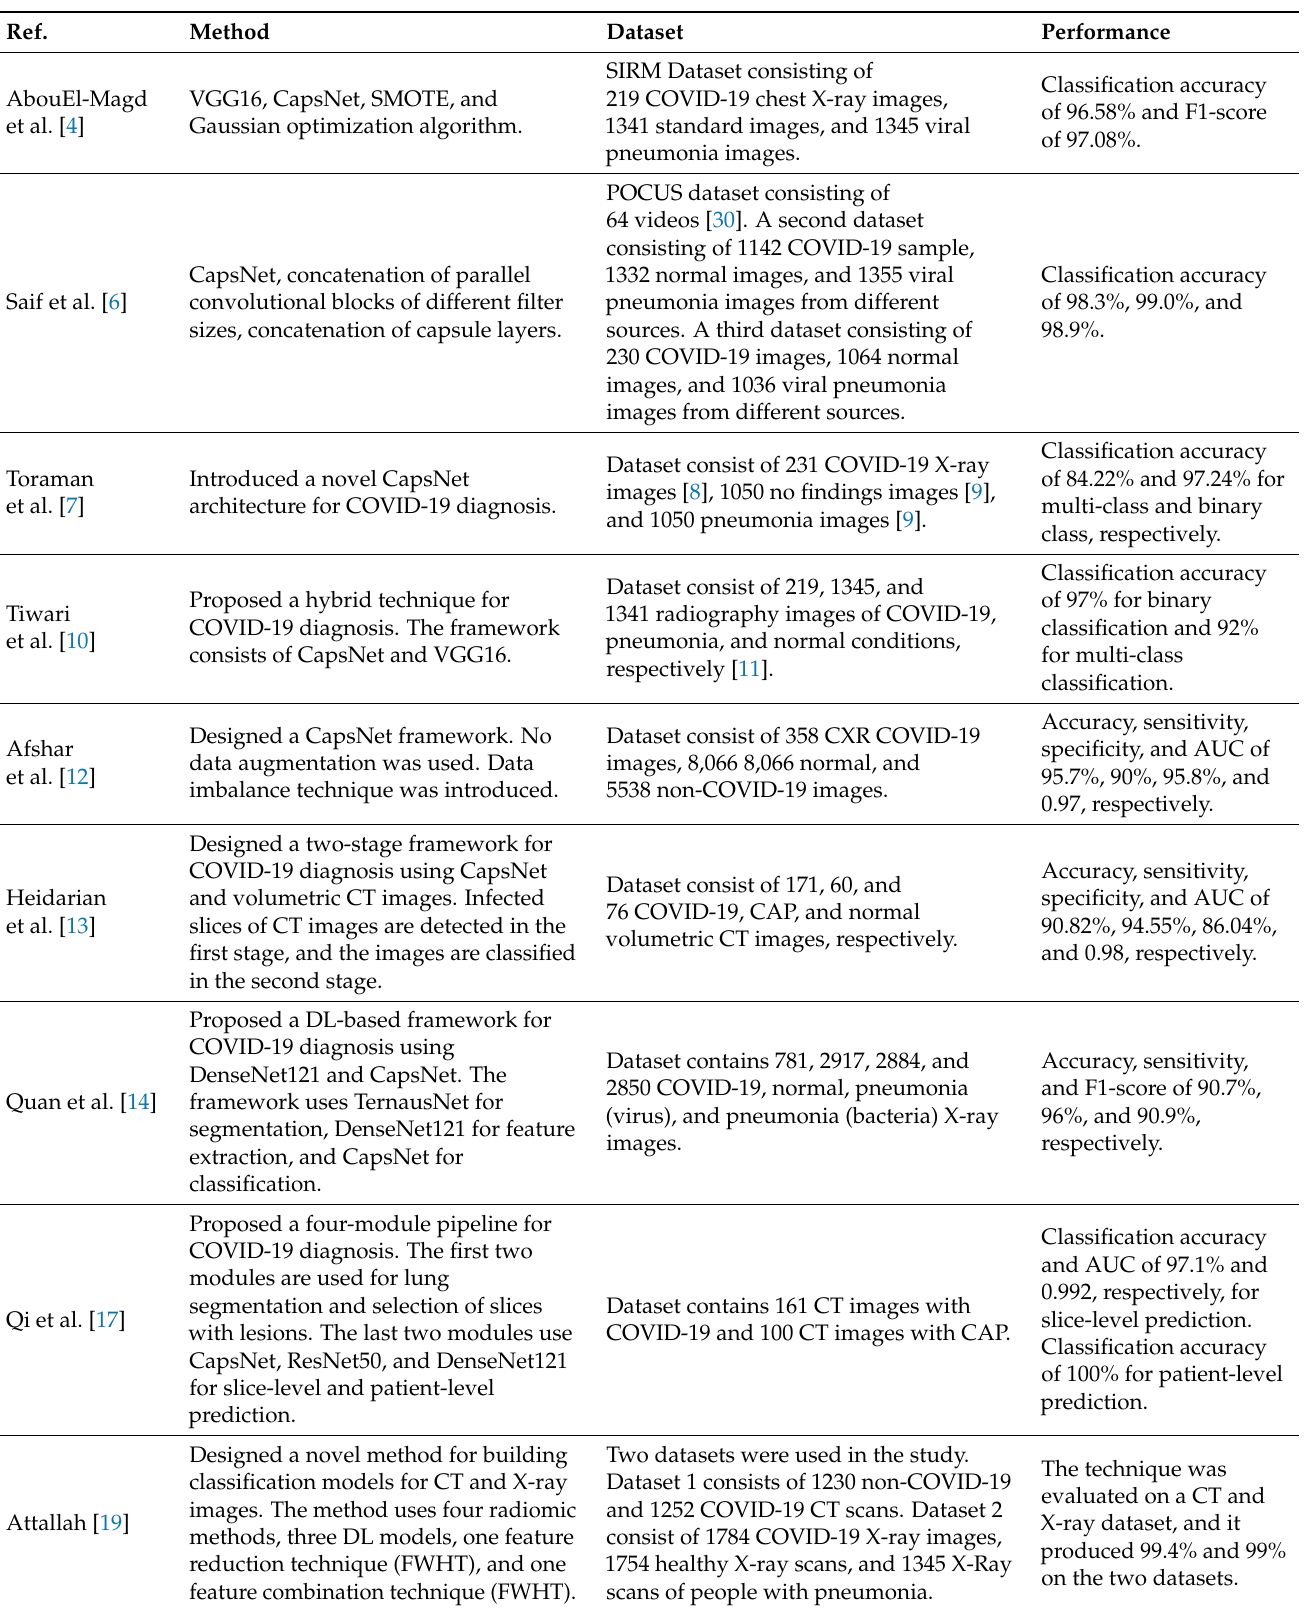
Table 1. Summary of related